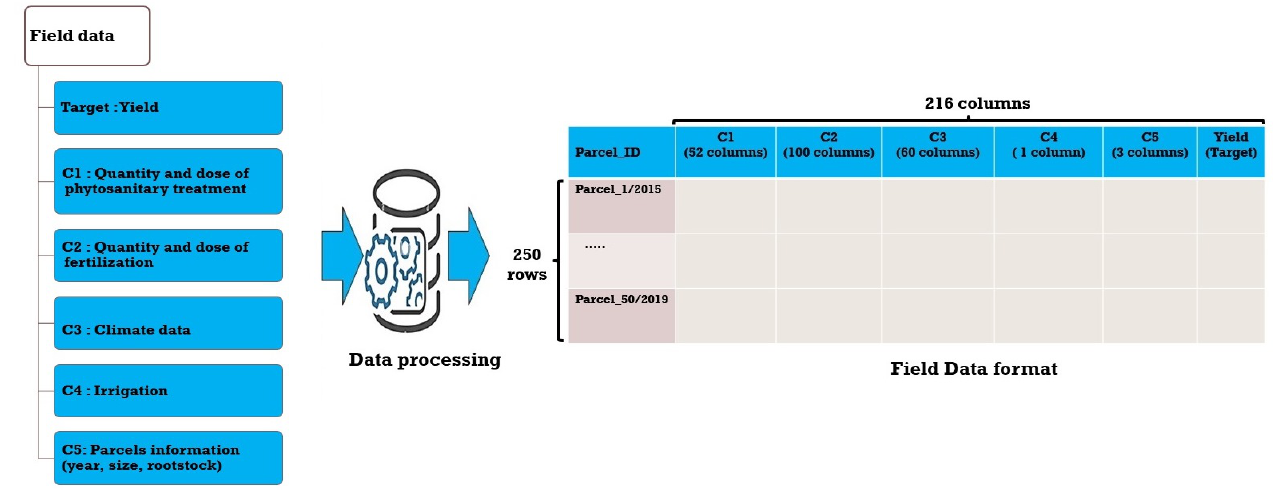
Figure 1. Field data